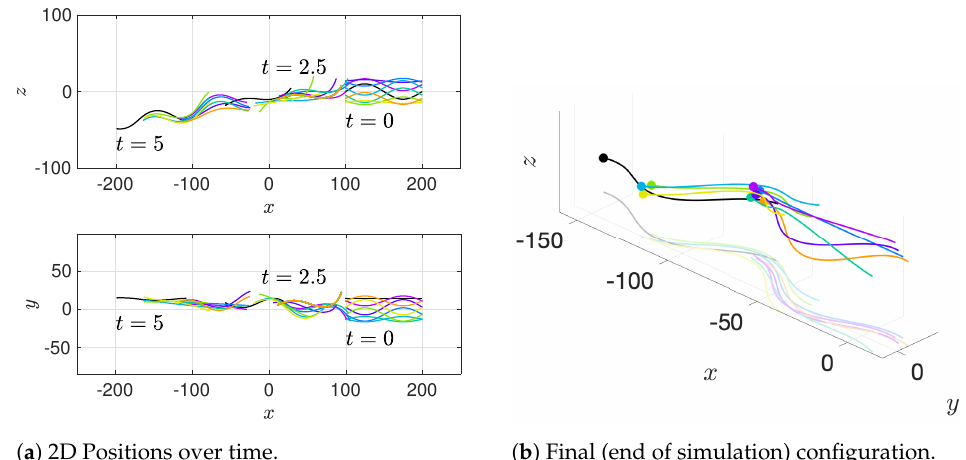
Figure 17. Positions of flagella in sperm train model, starting from the cylindrical initial configuration depicted in Figure 4a. All units are in µ m. Panel ( a ) shows 2D snapshots of locations of flagella over time in 2D, overlaid. Times shown are every 2.5 s or 25 beats. Initial and middle time points are shown in lighter colors, with the initial configuration to the far right. Final time point positions are shown in bolder colors towards the left. Head positions started near x = 100 µ m and flagella move in the negative x -direction. Panel ( b ) shows the positions of flagella at the end of the simulation, forming a phase-locked train. See Supplemental Material Movie S9.